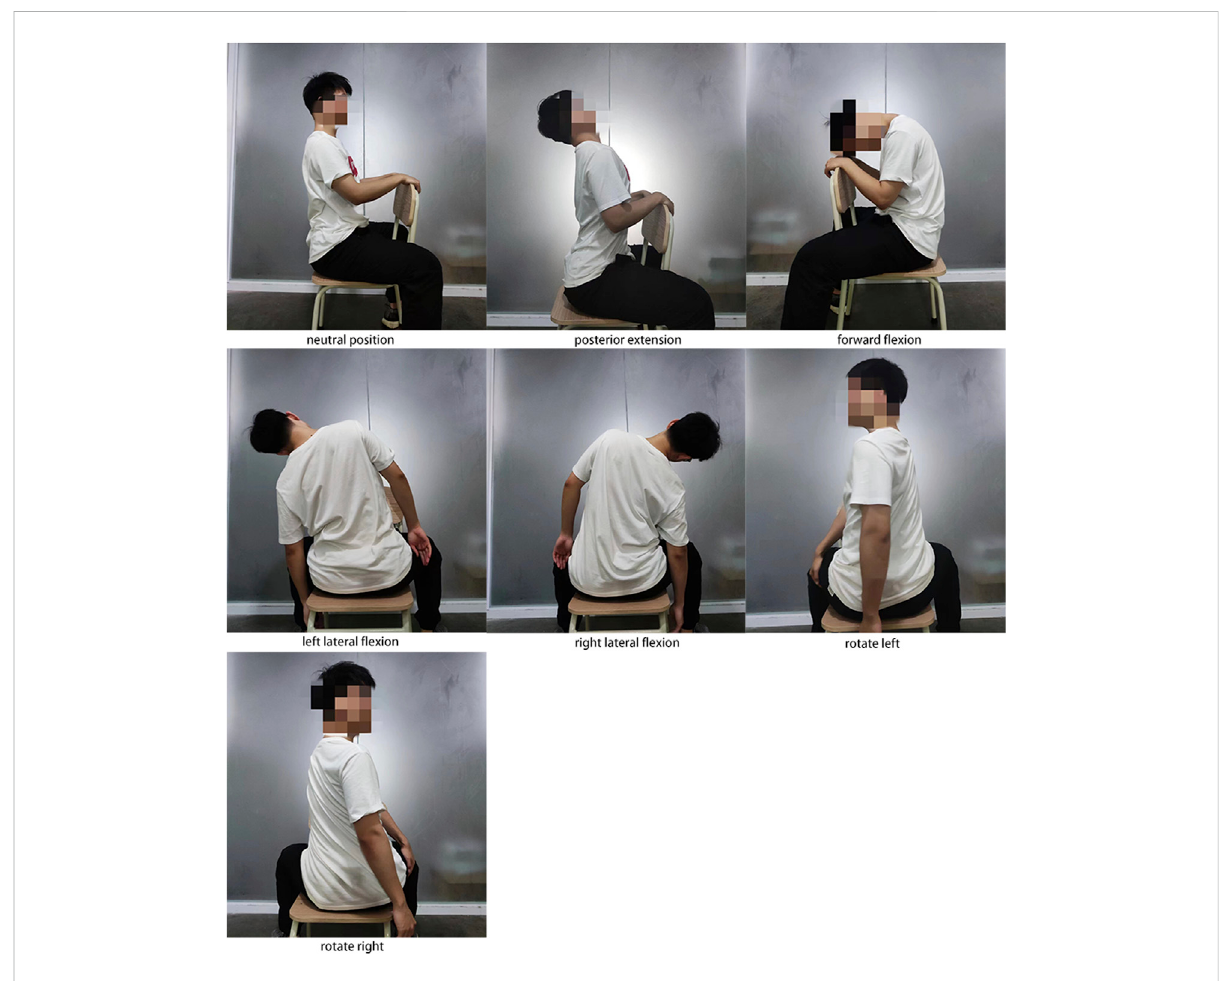
FIGURE 1 Schematic diagram of seven